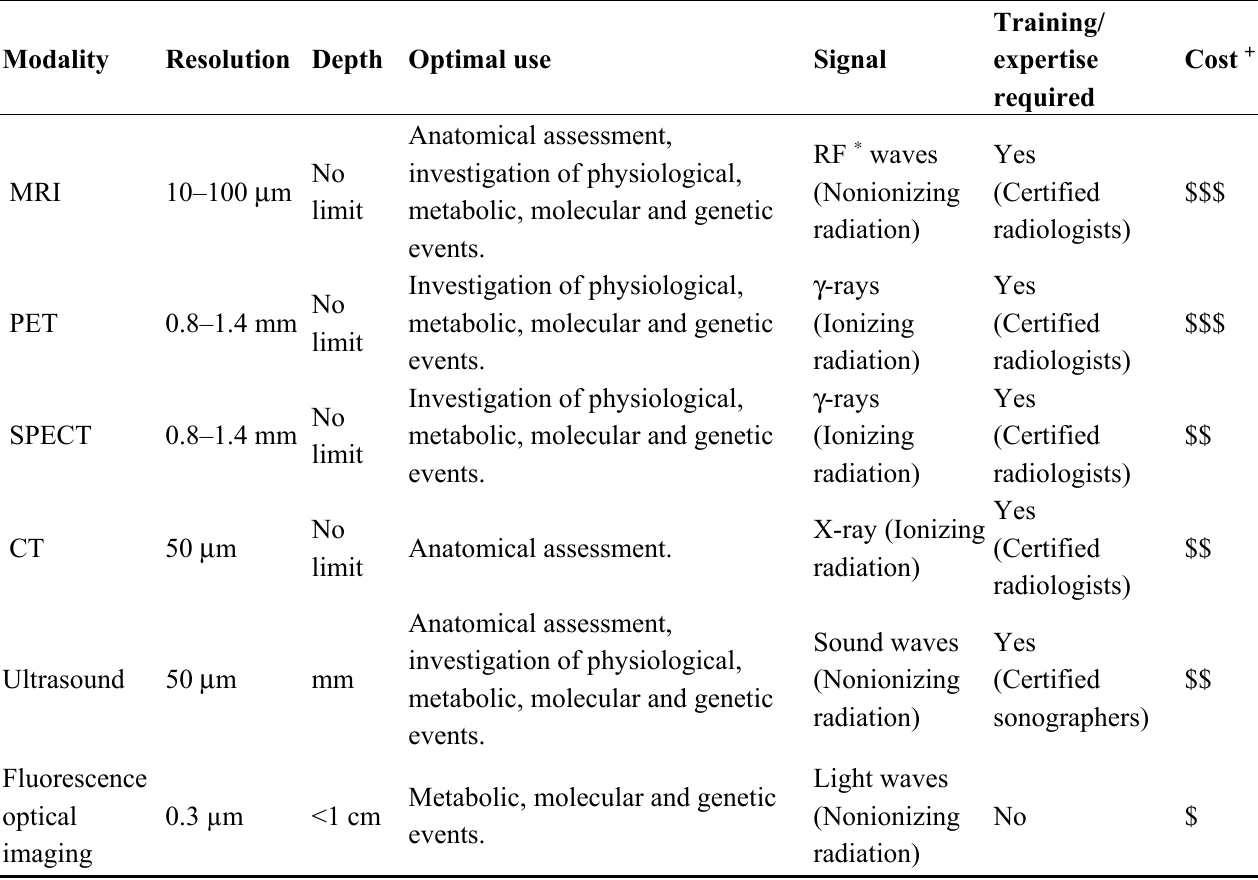
Table 1. Overview of imaging systems for small